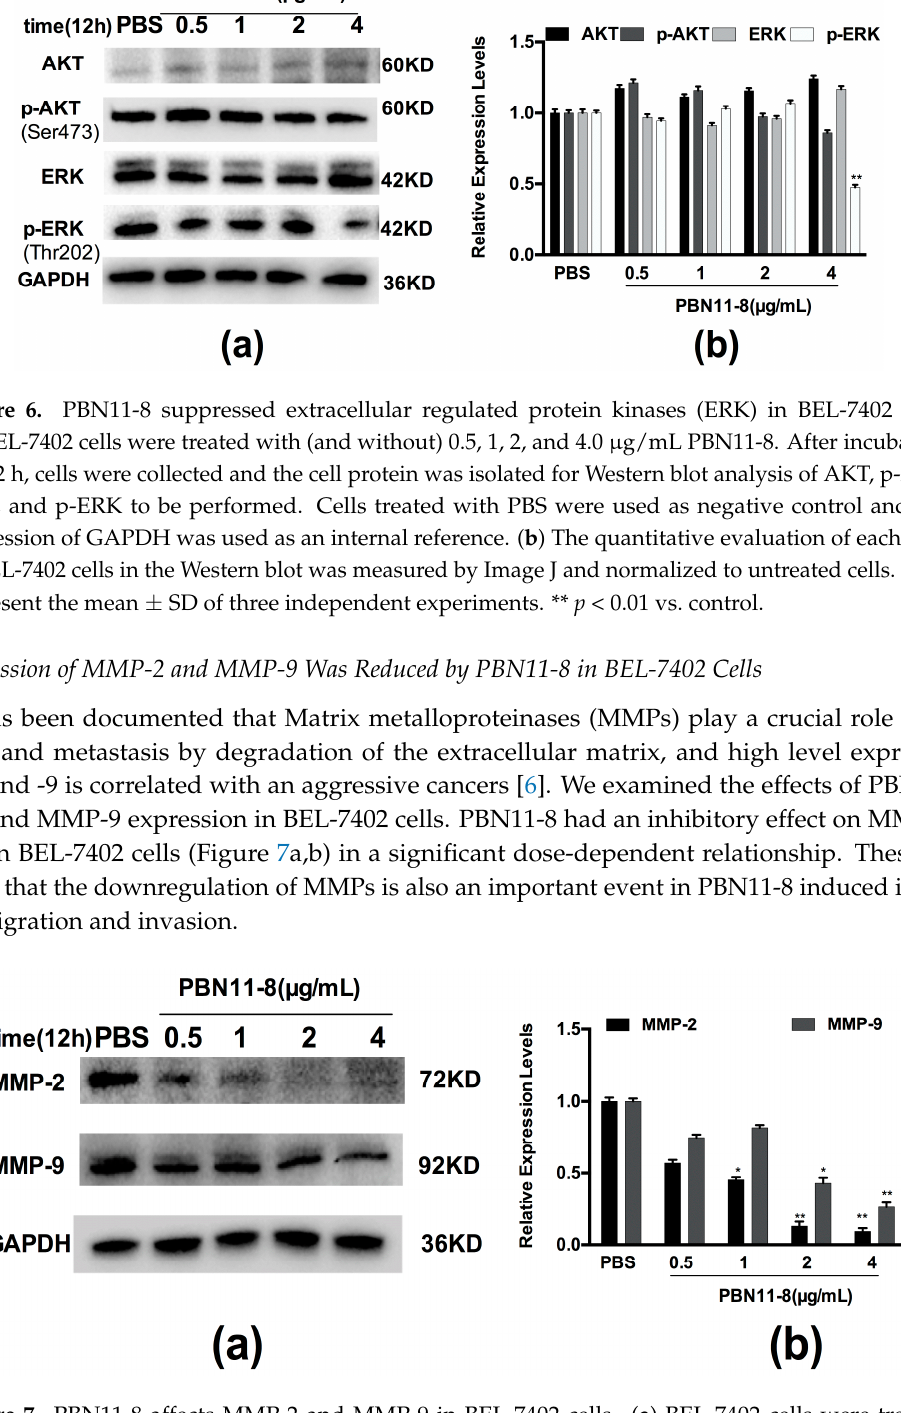
Figure 7. PBN11-8 affects MMP-2 and MMP-9 in BEL-7402 cells. ( a ) BEL-7402 cells were treated with (and without) 0.5, 1, 2, and 4.0 µg/mL PBN11-8. After incubation for 12 h, cells were collected and the cell protein was isolated for Western blot analysis of MMP-2 and MMP-9. Cells treated with PBS were used as negative control and the expression of GAPDH was used as an internal reference. The quantitative evaluation of each lane of ( b ) BEL-7402 cells was measured by Image J and normalized to untreated cells. Data represent the mean ± SD of three independent experiments. * p < 0.05 vs. control; and ** p < 0.01 vs. control.